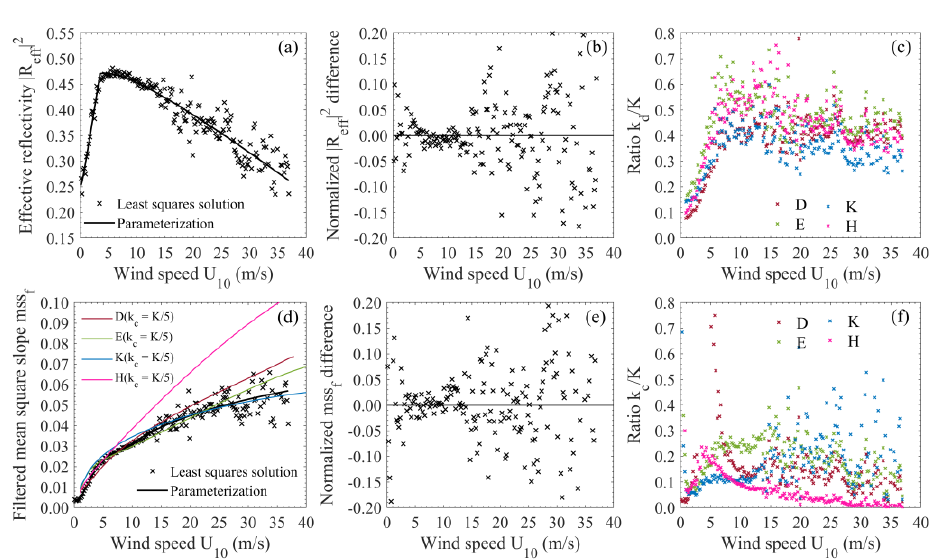
Figure 10. ( a ) Least squares solutions for | R e ff | 2 with the GO model (crosses) and the corresponding parameterization based on a least square fitting of the solutions at 0 < U 10 < 37 m / s (black line). ( b ) Parameterization accuracy: Parameterized | R e ff | 2 /| R e ff | 2 − 1. ( c ) Ratio of the low-limit cuto ff wave number k d to the radar wave number K as a function of wind speed for the D, E, K, and H spectra. ( d ) Solutions for the filtered mss (crosses), the best-fit parameterization (black line), and their comparison with those obtained by integrating the D, E, K, and H spectral functions from zero to an upper cuto ff wave number k c = K / 5. ( e ) Parameterization accuracy: Parameterized mss f / mss f − 1. ( f ) Ratio of k c to K versus wind speed. Color sequence for D, E, K, and H spectra is dark red, olive green, dodger blue, and deep pink.